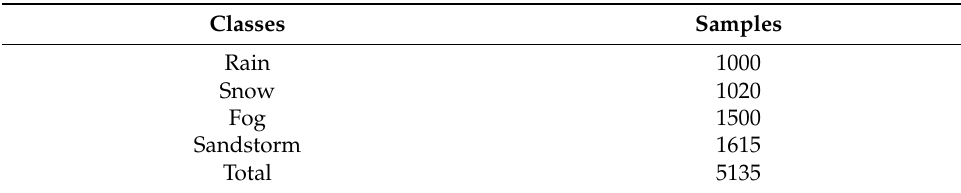
Figure 2. Schematic diagram of the augmented dataset. Table 1. Breakdown of dataset categories and